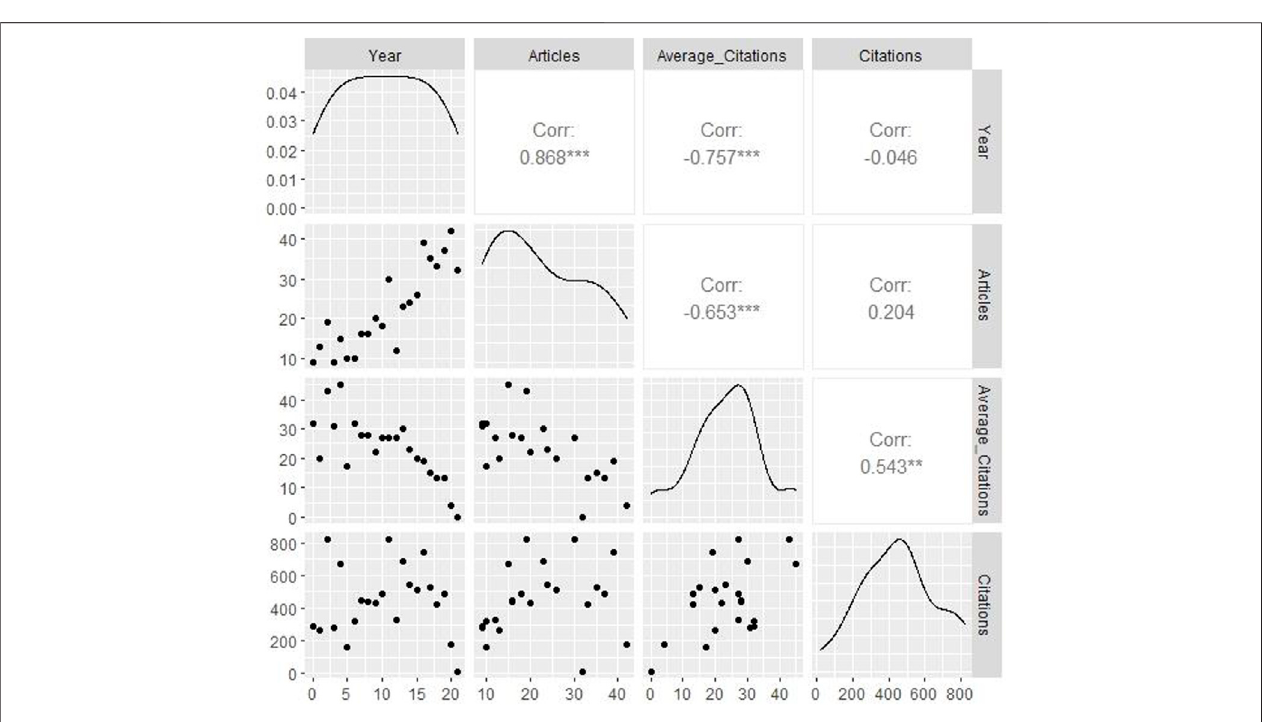
FIGURE 2 | Matrix scatter